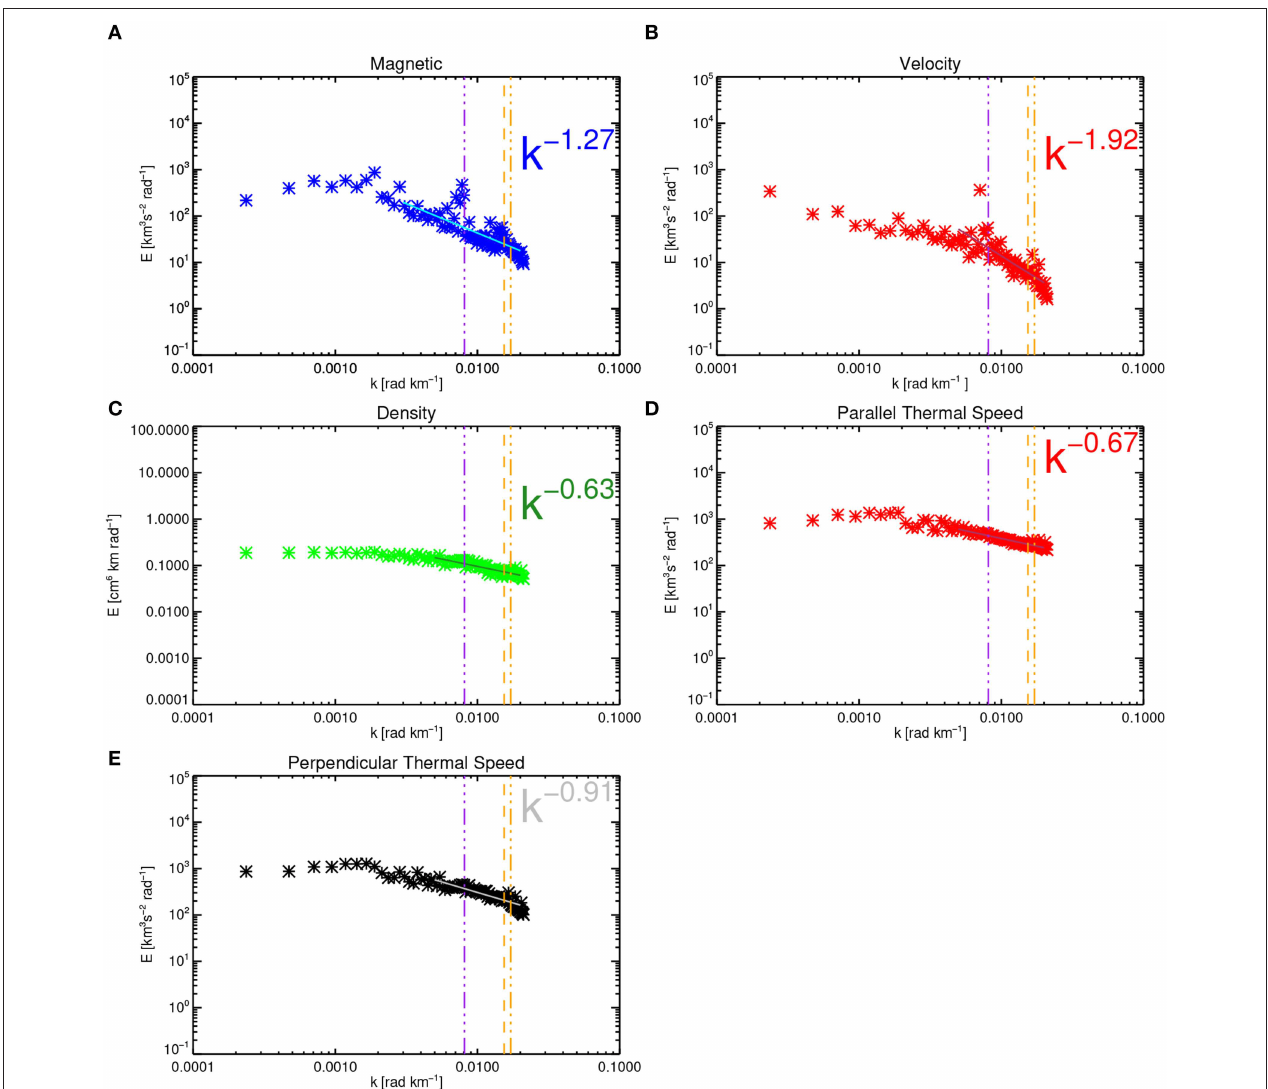
FIGURE 6 | The same as Figure 5 but for the perpendicular